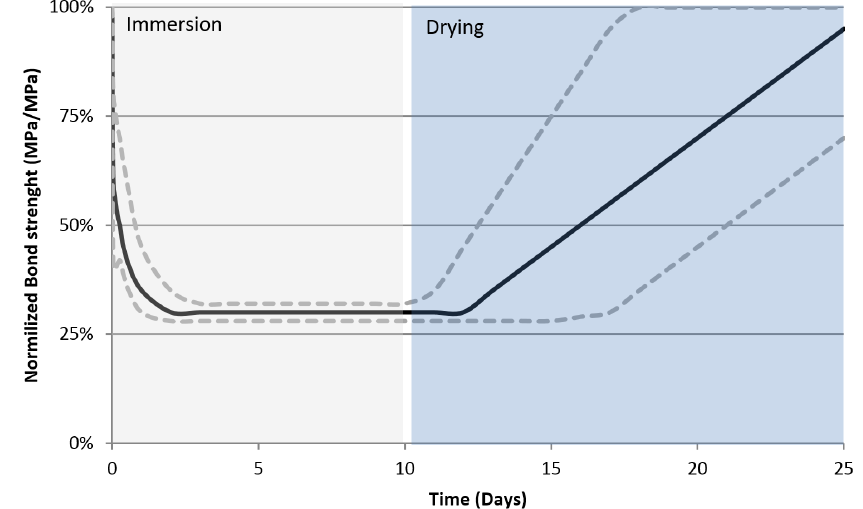
Figure 9. Proposed generic behavior based on the experimental program.